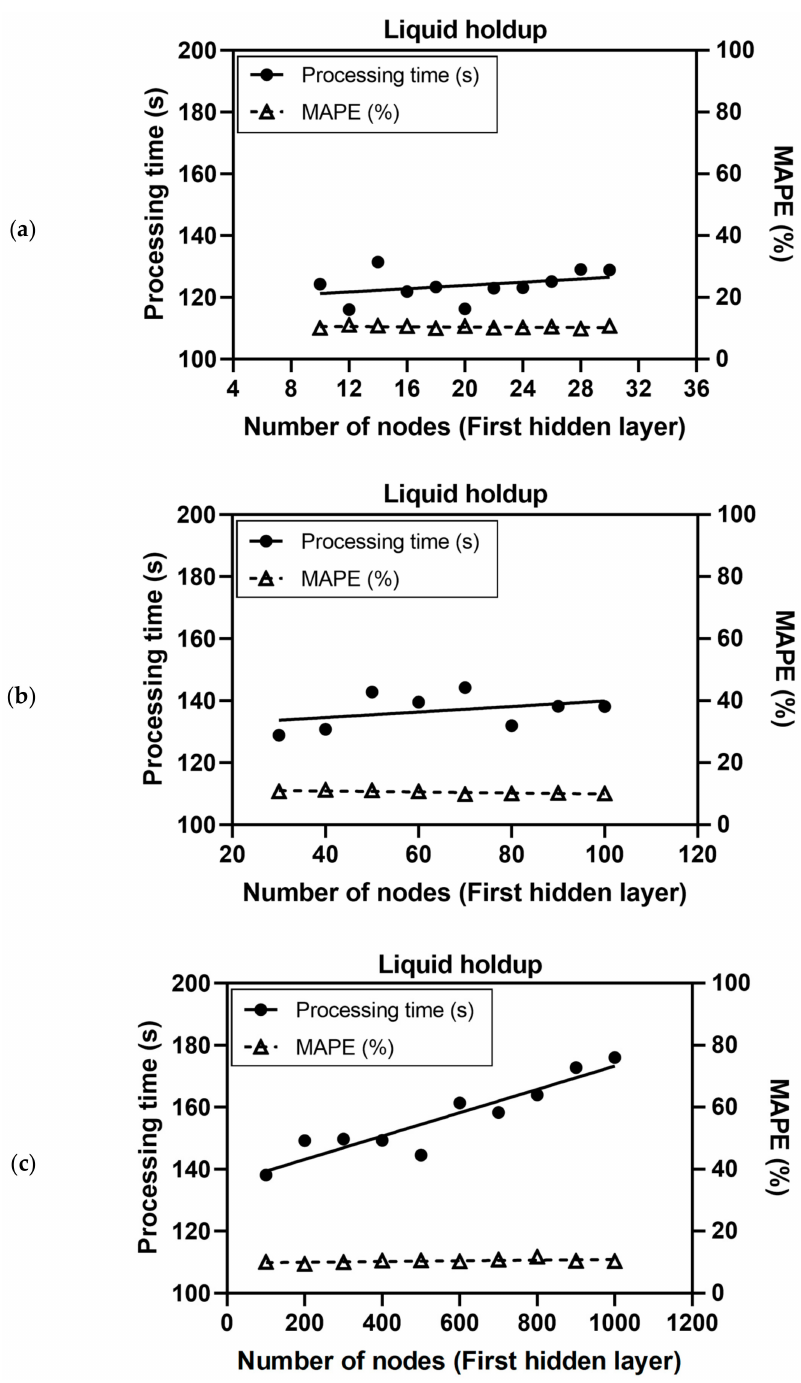
Figure 3. Processing time and training accuracy of the liquid holdup (unitless) for the validation data (31 data points) in relation to the number of nodes in the first hidden layer ( H DNN1 ) in the range of ( a ) 10 to 30, ( b ) 30 to 100, and ( c ) 100 to